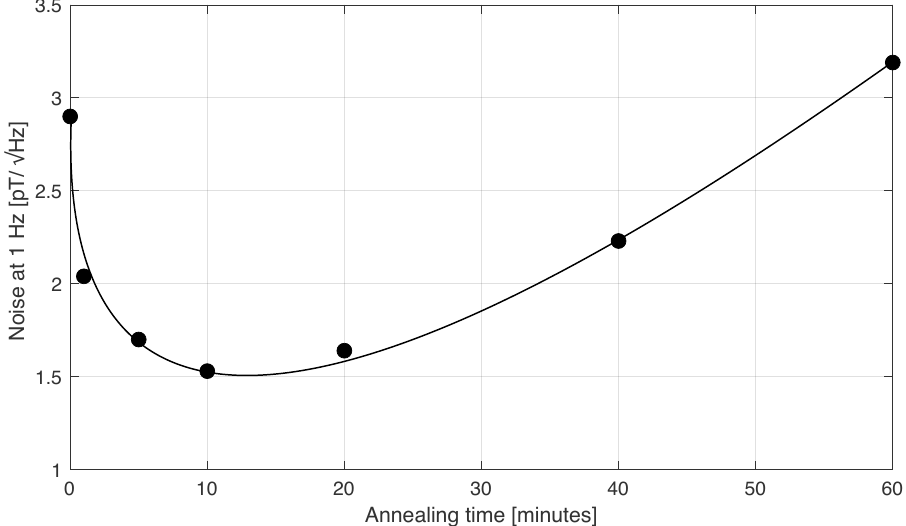
Figure 1. Dependence of the noise at 1 Hz of an orthogonal fluxgate in fundamental mode based on a single amorphous wire with ( Co 0.94 Fe 0.06 ) 72.5 Si 12.5 B 15 composition vs. annealing time.